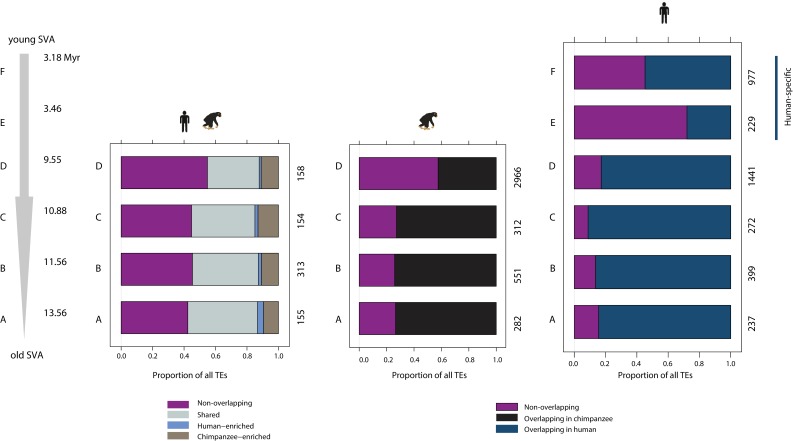
Species-specific SVA elements overlap H3K9me3 regions less frequently than orthologous SVAs.Left panel: overlap of orthologous SVA elements by orthologous H3K9me3 regions. Middle panel: all SVA elements in the chimpanzee genome and the proportion that overlap all H3K9me3 regions identified in chimpanzee. Right panel: all SVA elements in the human genome and the proportion that overlap all H3K9me3 regions identified in human. The estimated age of each of the six SVA types is shown in millions of years (Myr)(Wang et al., 2005).